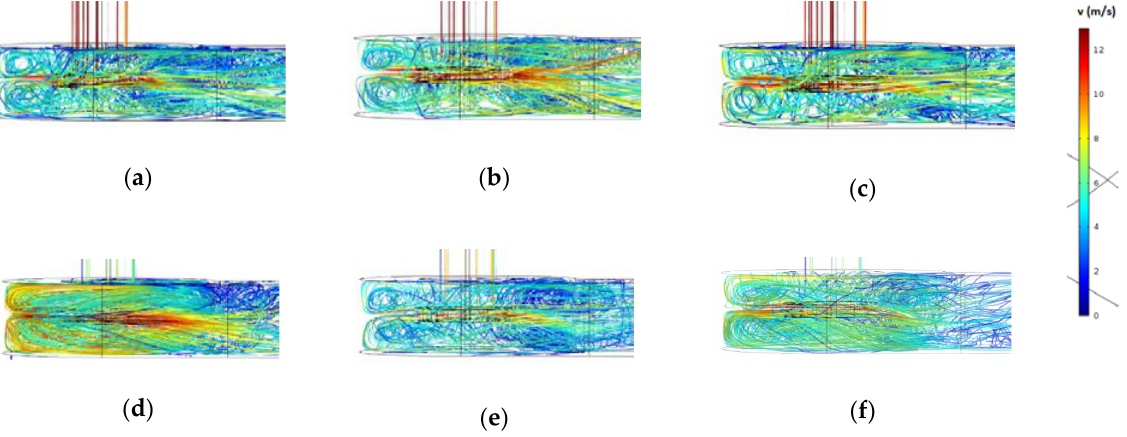
Figure 8. Velocity streamlines near the impeller for different rotational speeds: ( a ) N = 750 rpm; ( b ) N = 1050 rpm; ( c ) N = 1500 rpm; ( d ) N = 1600; ( e ) N = 1800 rpm; ( f ) N = 1850